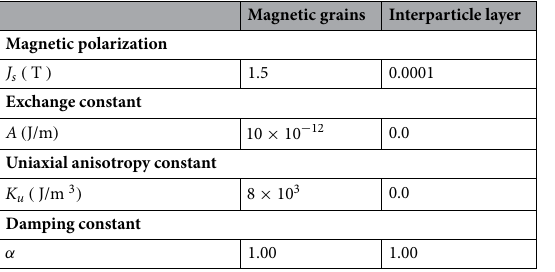
Table 2. Micromagnetic material parameters used within the magnetic grains as well as for the non-magnetic interparticle layer. The easy axes of the uniaxial anisotropy are randomly distributed.